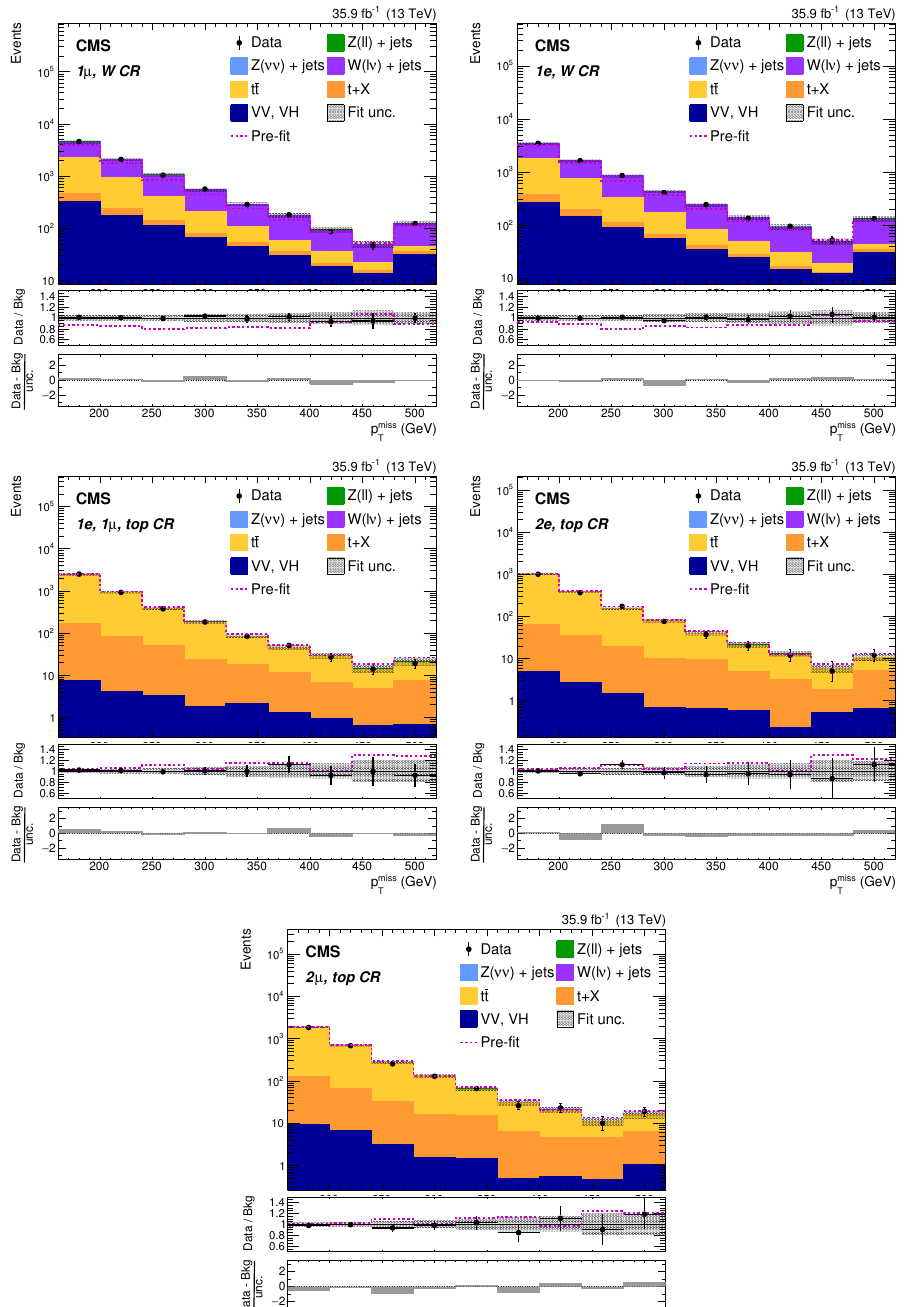
Figure 2 . Background-only post-(cid:12)t p miss distributions for the CRs of the SL selection. The total T theory signal (t = t+DM and tt+DM summed together) is negligible and therefore is not shown. The last bin contains over(cid:13)ow events. The dashed magenta lines show the total pre-(cid:12)t background expectation in the upper panels, and the ratio of pre-(cid:12)t total background to post-(cid:12)t total background in the middle panels. The lower panels show the di(cid:11)erence between observed and post-(cid:12)t total background divided by the full statistical and systematic uncertainties.